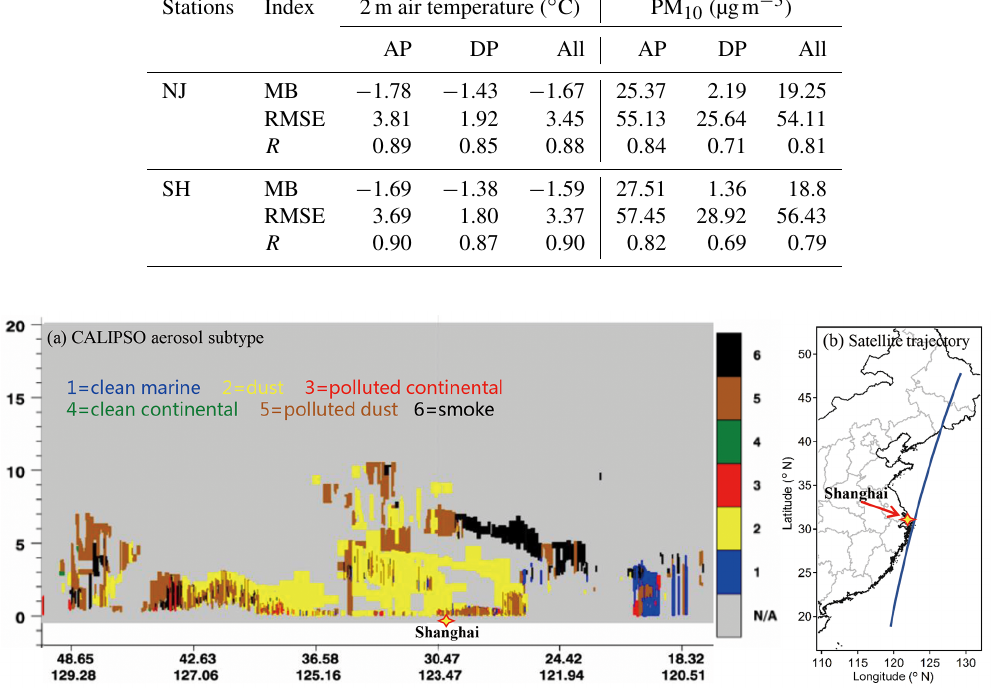
al. (2009) also reported the WCBs could transport megaci- ties’ plumes in the North China Plain to the mid-troposphere over northeastern